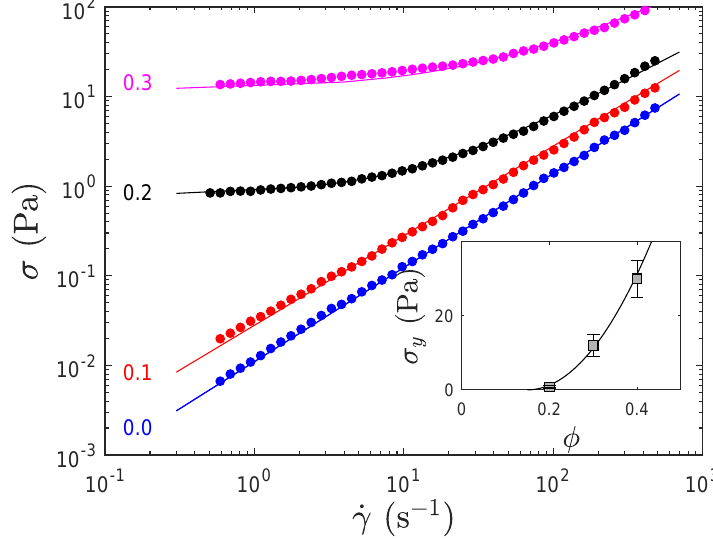
Figure 2. Flow curves of different PSS-stabilized formulations where the volume fraction of calcite is noticed in the figure. Some yield-stress develops between 0.1 and 0.2 calcite volume fraction. The straight lines describe a purely Newtonian fluid whereas above 0.2 volume fraction of calcite, the fluid obeys a Herschel–Buckley behavior ( σ = σ y + K ˙ γ α ). Insert: Yield stress σ y that develops above 0.1–0.2 volume fraction of calcite. The solid line is a quadratic fit (a guide) that suggests that the critical yield stress occurs at 0.15.